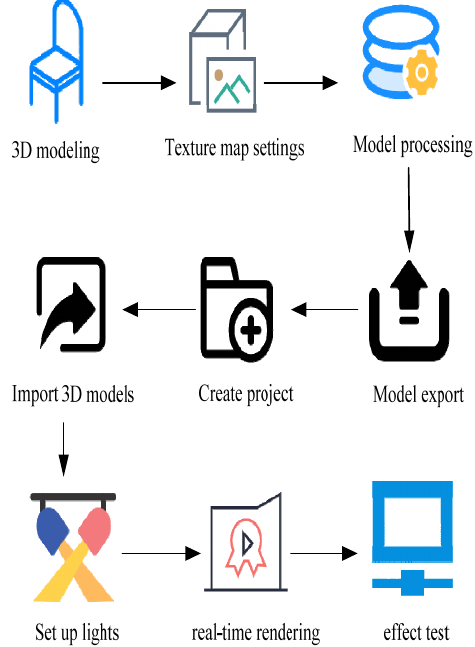
Figure 2. Design development process.